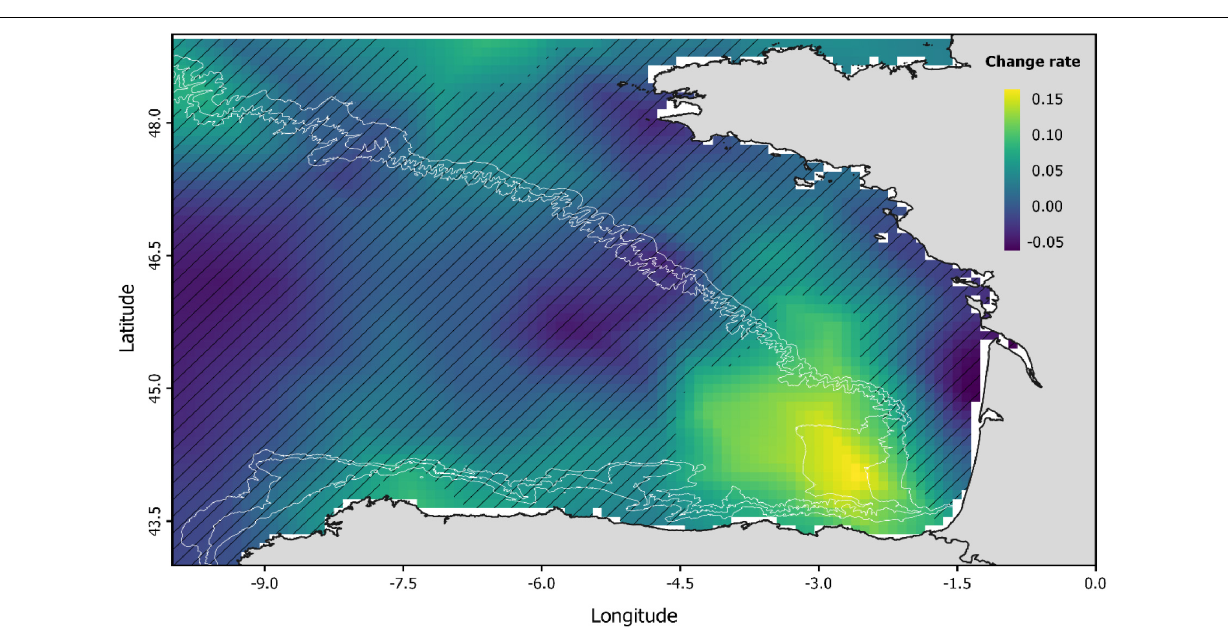
FIGURE 4 | Spatio-temporal changes in the abundance of common dolphin (predicted by the baseline model) illustrated by means of the change rate (the slope of the linear regression). Hatched areas indicate those areas where change rate is not significant ( p >